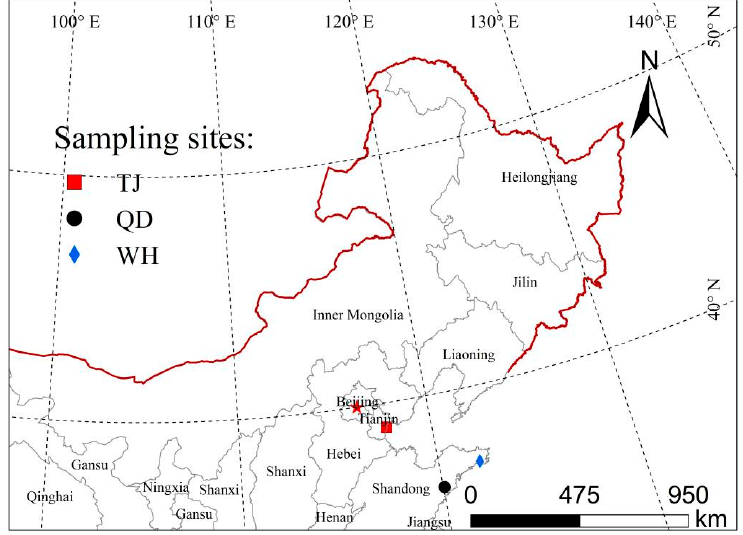
Figure 1. Geographical locations of the sampling sites.